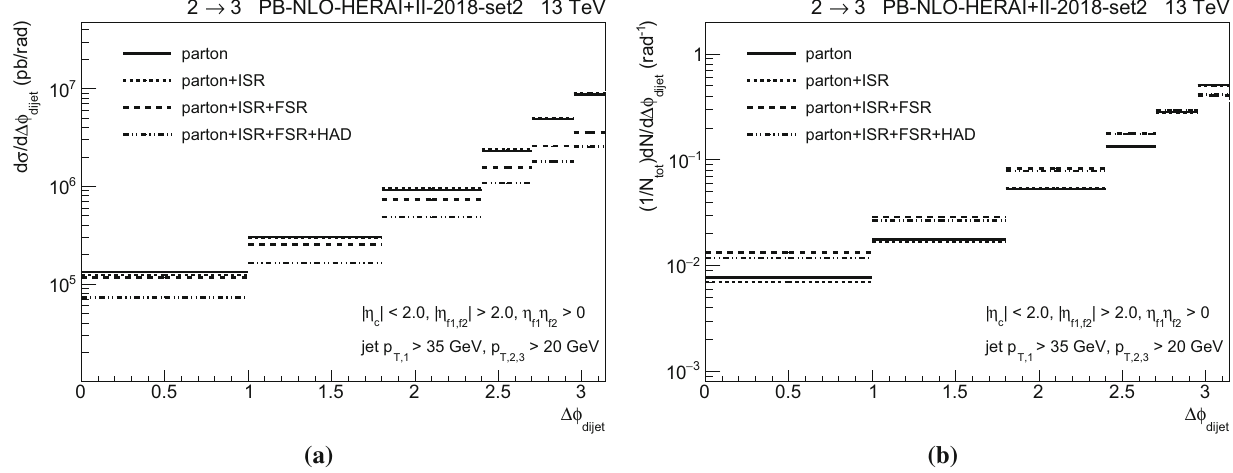
Fig. 5 Full off-shell predictions at parton level for 2 → 3 processes with subsequently adding ISR, FSR, and hadronisation. The PB-NLO- HERAI+II-2018-set2 PDF is used for all predictions. Shown in absolute cross sections ( a ) and normalised distributions ( b )